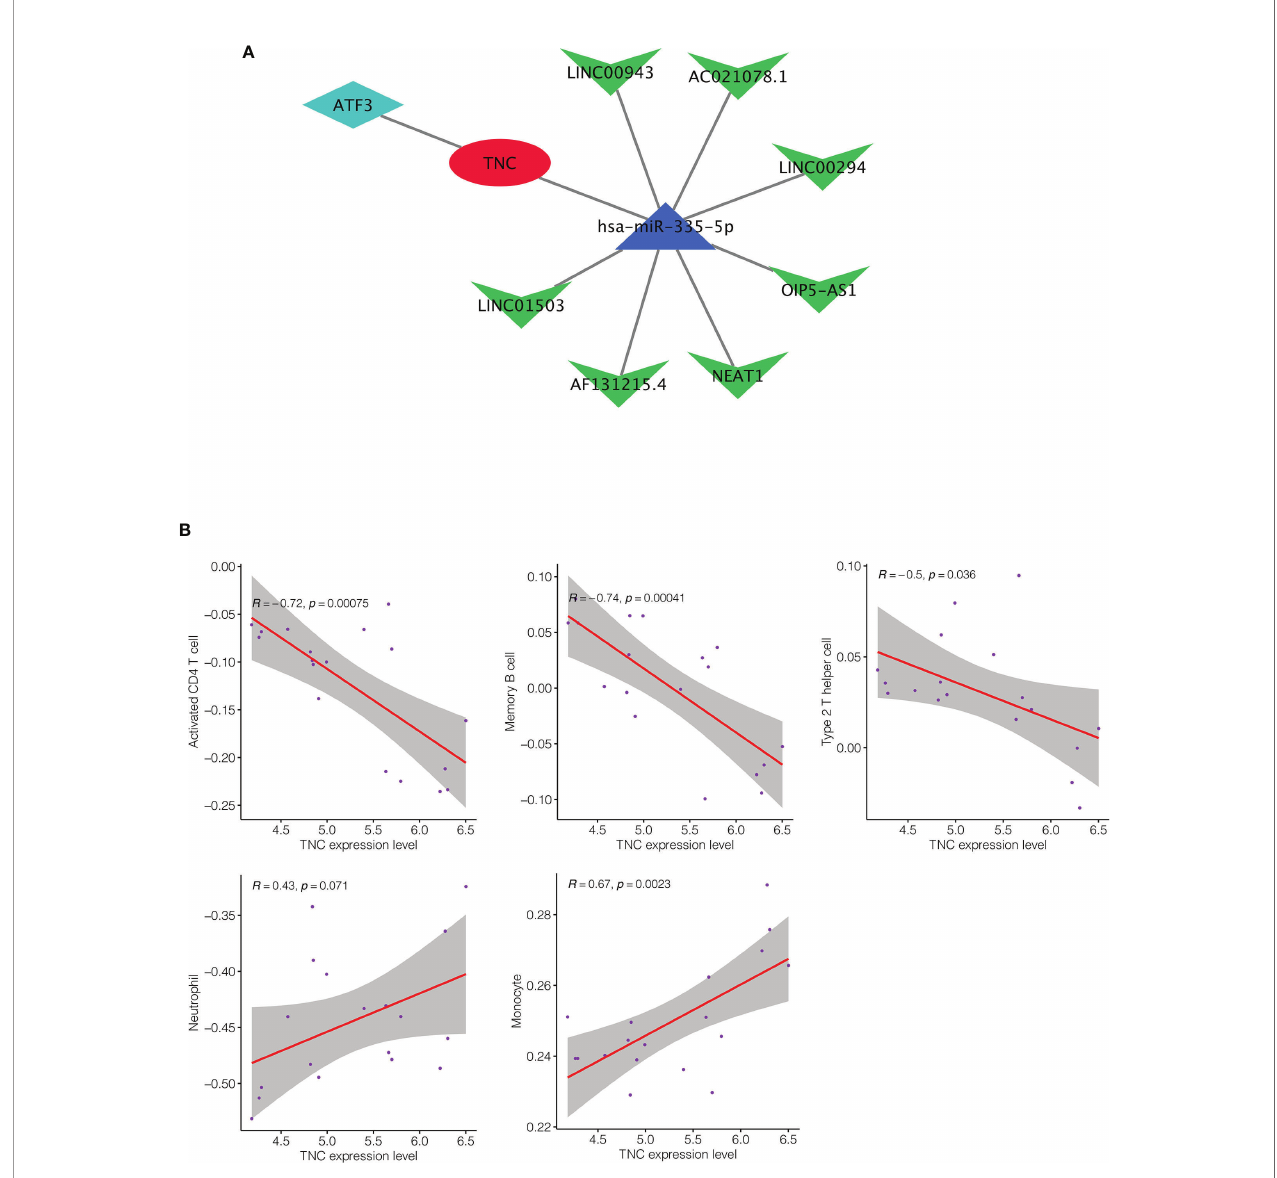
FIGURE 1 | (A) The competitive endogenous RNA (ceRNA) regulatory network of TNC in keloid. (B) Immune correlation analysis of TNC in keloid. TNC had a signi fi cant negative correlation with CD4+ T cells, memory B cells and Type 2 T helper cells in keloid. And TNC showed signi fi cant positive correlation with neutrophils and monocytes in